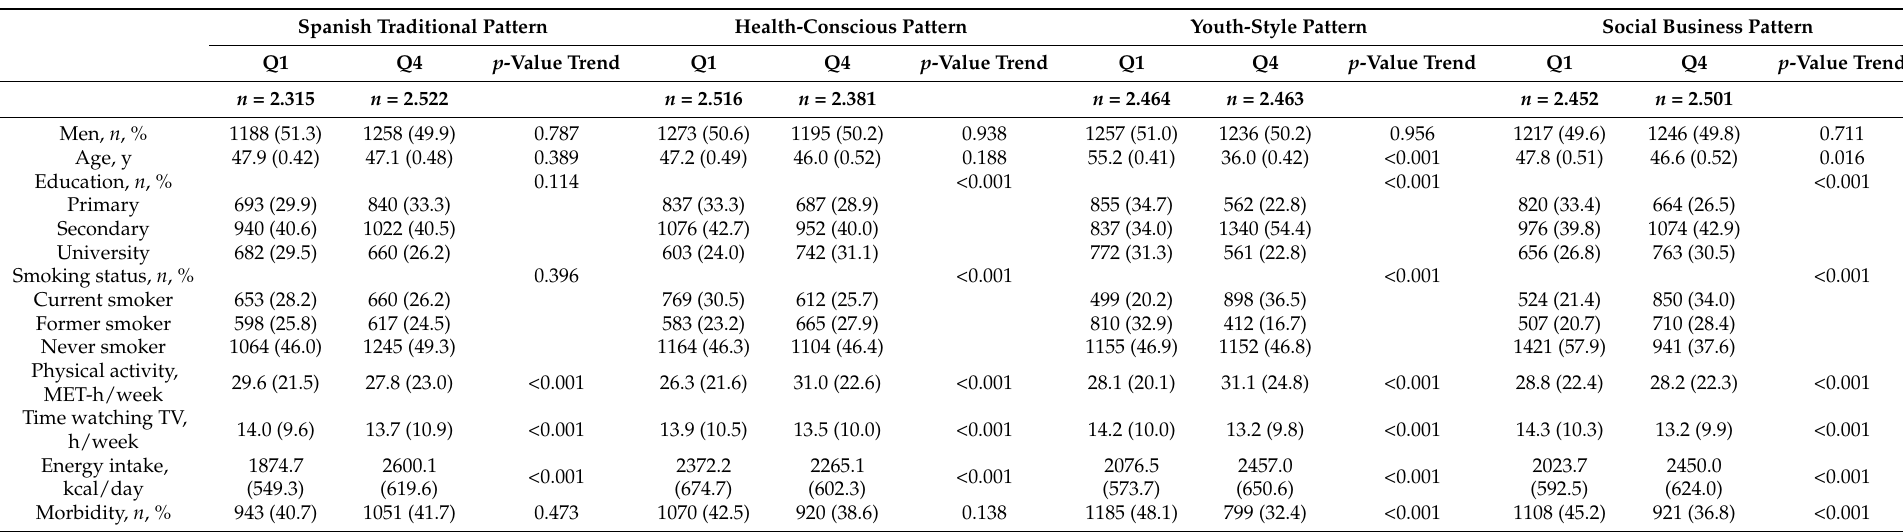
Table 2. Characteristics of the study participants by quartiles of adherence to the cooking and food preservation patterns. The ENRICA study 2008–2010. Spanish Traditional